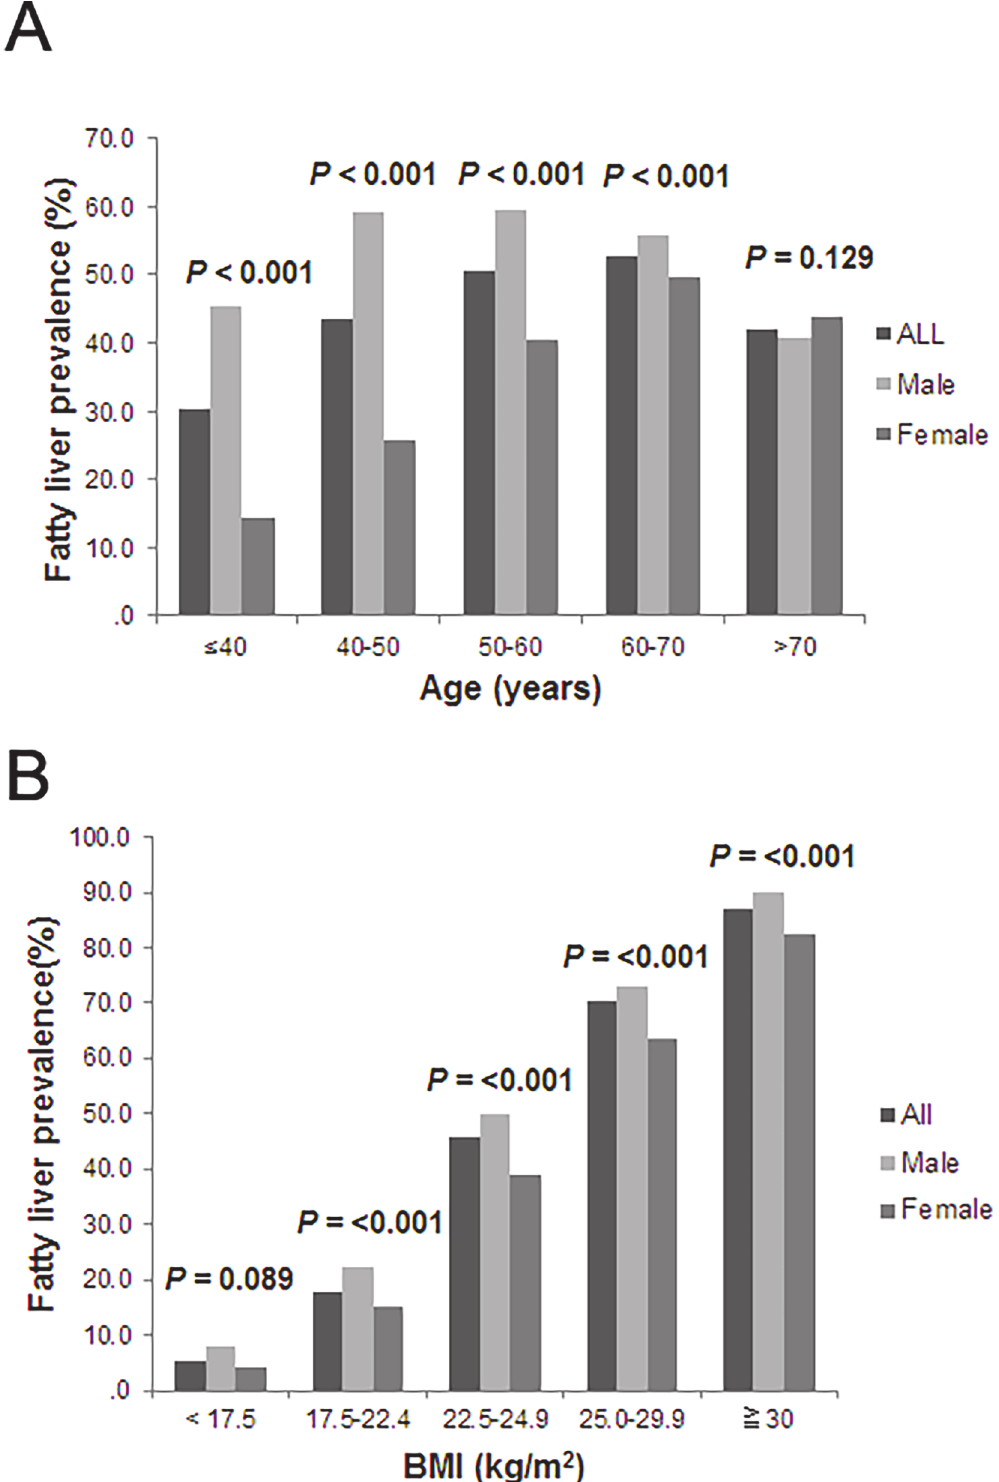
Fig 1. Comparison of the prevalence rate of ultrasonogrphic fatty liver between male and female subjects. (A) Comparison of ultrasonogrphic fatty liver prevalence rate between male and female subjects stratified by age. (B) Comparison of ultrasonogrphic fatty liver prevalence rate between male and female subjects stratified by body mass